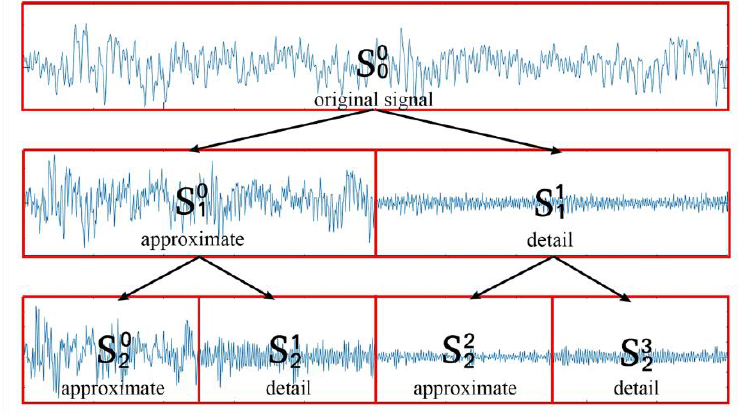
Figure 1. Tree structures of the wavelet packet transform.